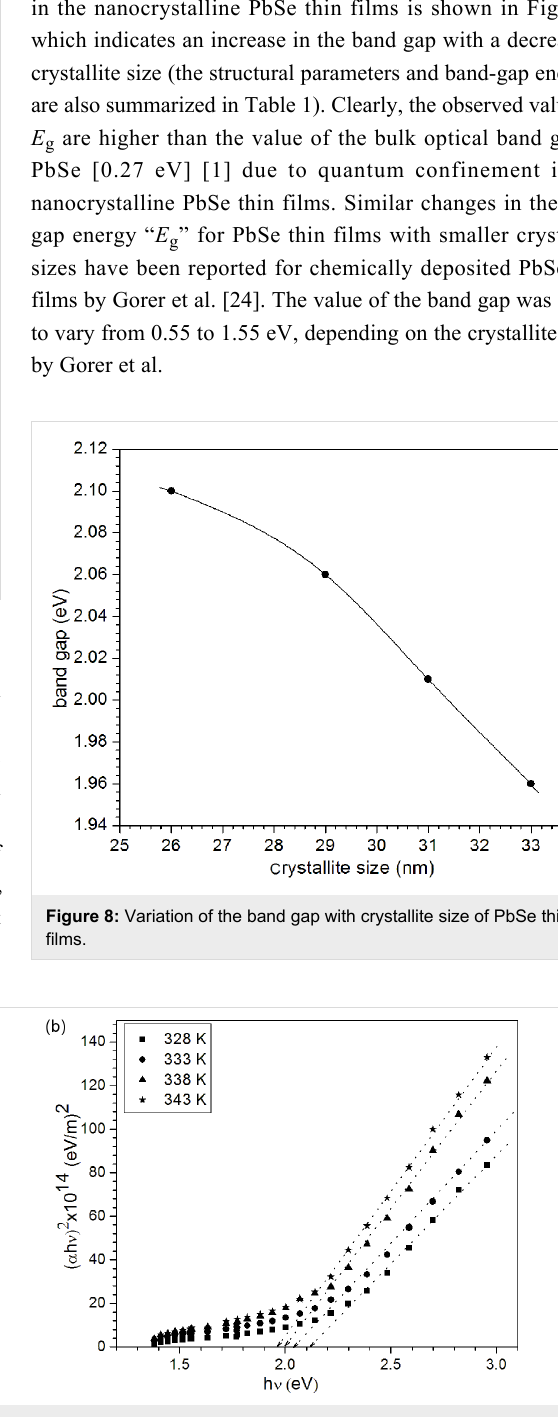
Figure 7: (a) UV absorption spectra; (b) ( α h ν ) 2 vs ( h ν ) plots of PbSe thin films.